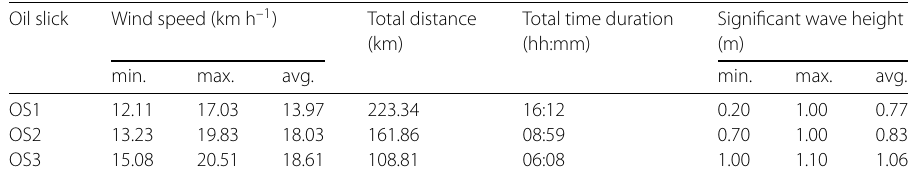
Table 2 The corresponding information of the three oil slicks on 6 December 2018, a fine weather day